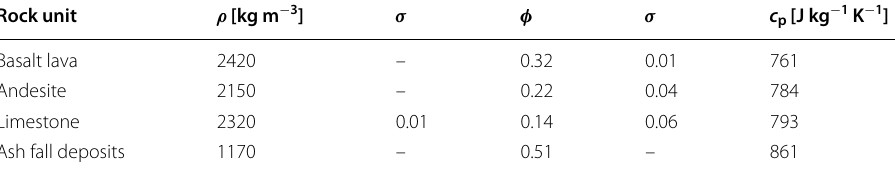
Table 1 Physical parameters of rocks, σ is the standard deviation (Weydt et al. 2020) Rock unit ρ [kg m − 3 ] σ φ σ c p [J kg − 1 K − 1 ] Basalt lava 2420 – 0.32 761 Andesite 2150